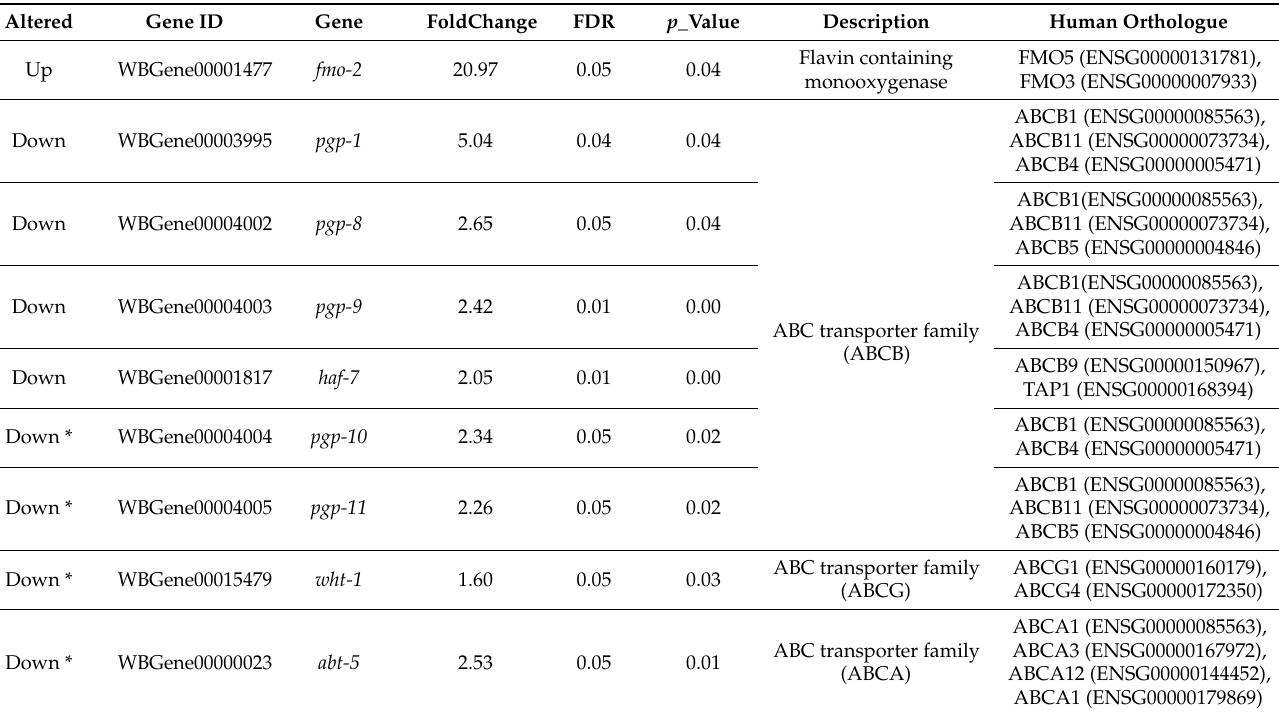
Table 1. ABC transporters and fmo-2 , which are differentially expressed genes in seb-3(eg696) gf animals, are prioritized to be involved in cholesterol